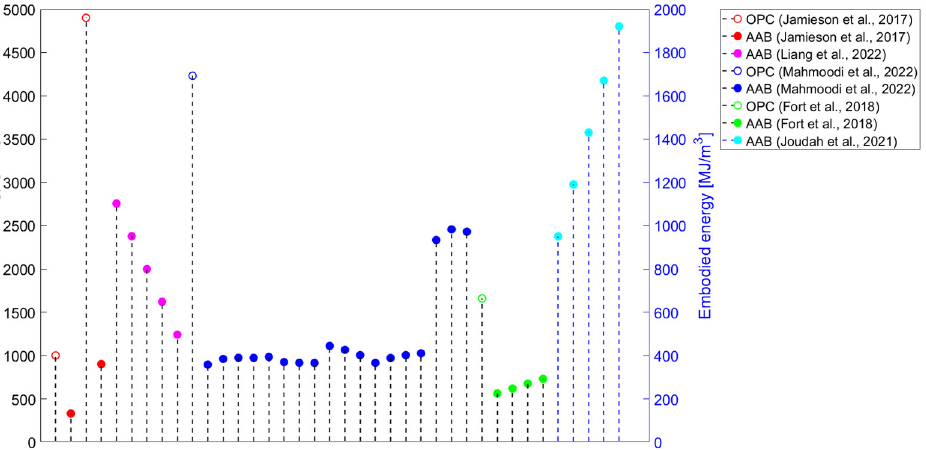
Figure 4. Embodied energy results for alkali-activated materials from the literature [19,46,48,130,145]. Table 3. Comparison between data regarding environmental impact assessments from the literature. Source Functional